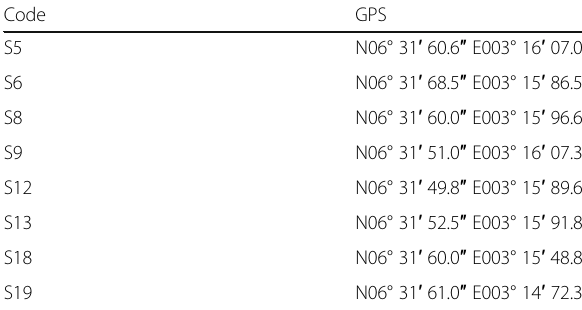
Table 1 Global positioning system (GPS) reading of the sampling